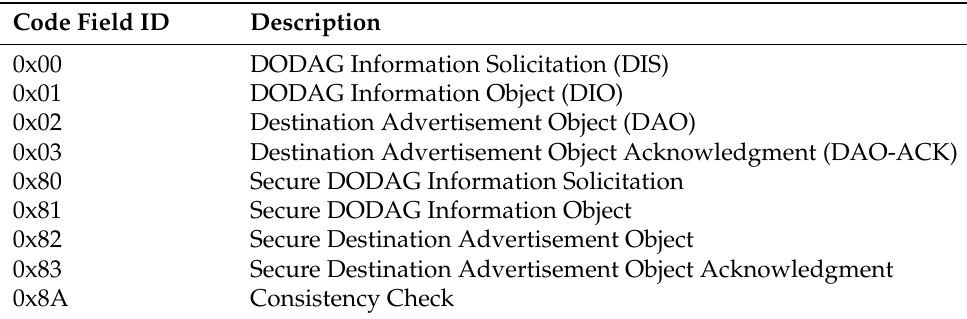
Table 1. Codes for RPL control message